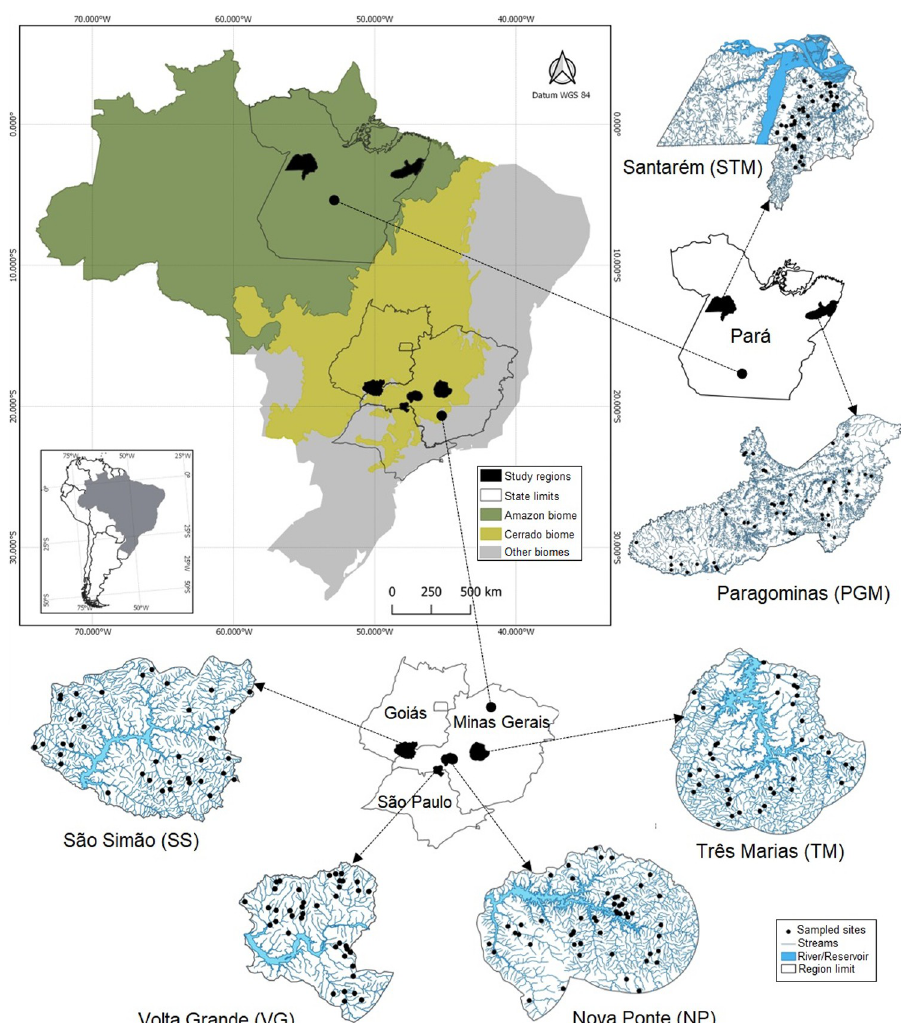
Fig 1. Location map. The study sample sites are shown within the six study regions across the two study biomes in